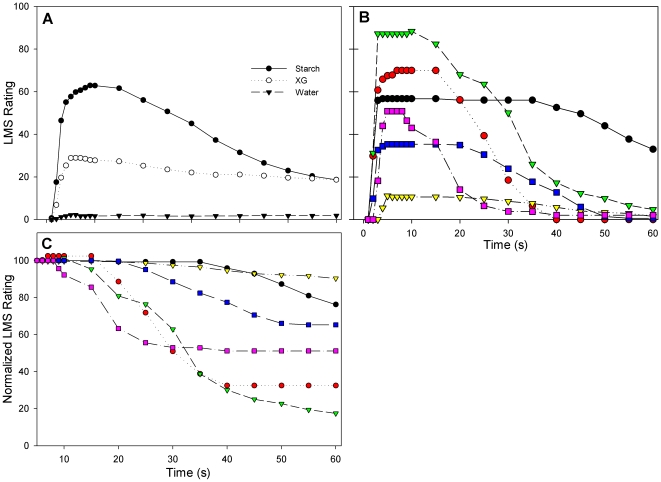
Subjects rated the viscosity of 6% starch, 1% xanthan gum, and water over the course of 60 seconds.Average time-intensity ratings for the three stimuli (A). As demonstrated by LMS ratings from six individuals (each portrayed by a different colored line/shape), subjects were highly variable in their use of the LMS scale when rating starch viscosity during the trial (B). LMS ratings were normalized to 100 at 5 seconds in order to remove subjective noise and enable observation of the effects of amylase on viscosity ratings (C). Note that Panels B and C contain LMS rating data from the same six subjects; each individual is represented by the same color line in each panel.